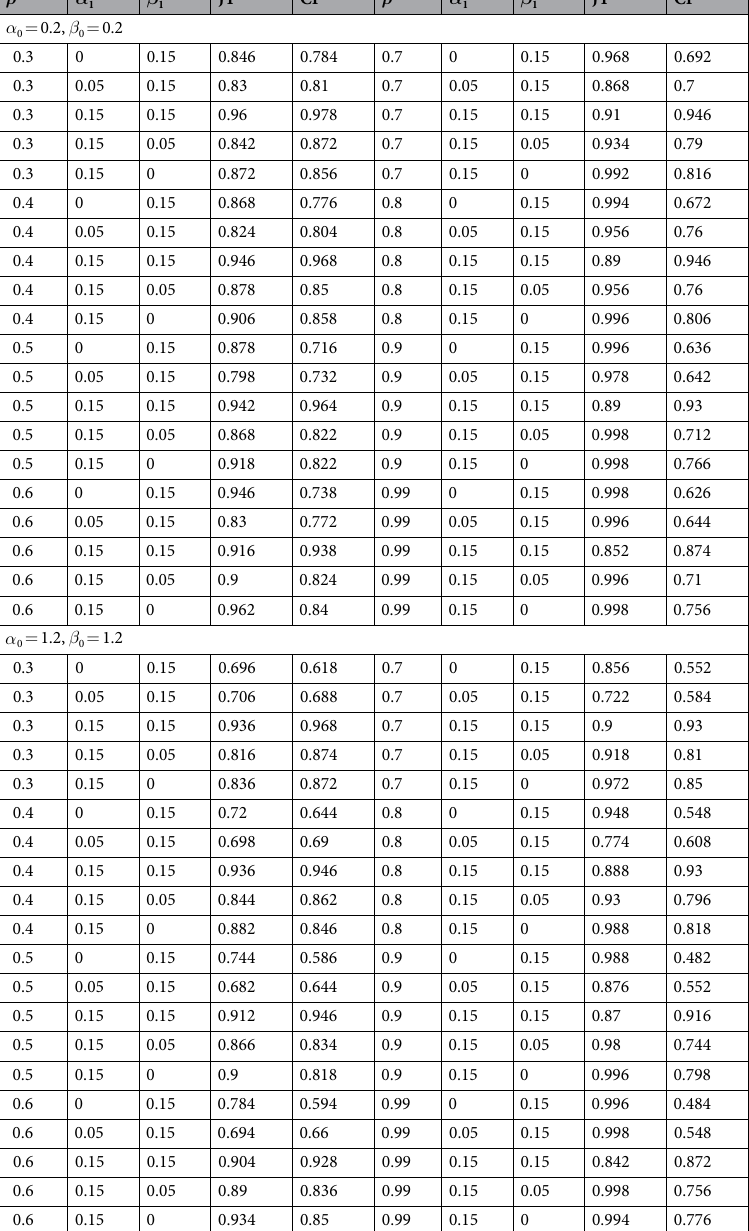
Table 4. Empirical powers for tests JT and CP with 4 ordinal categories( k =